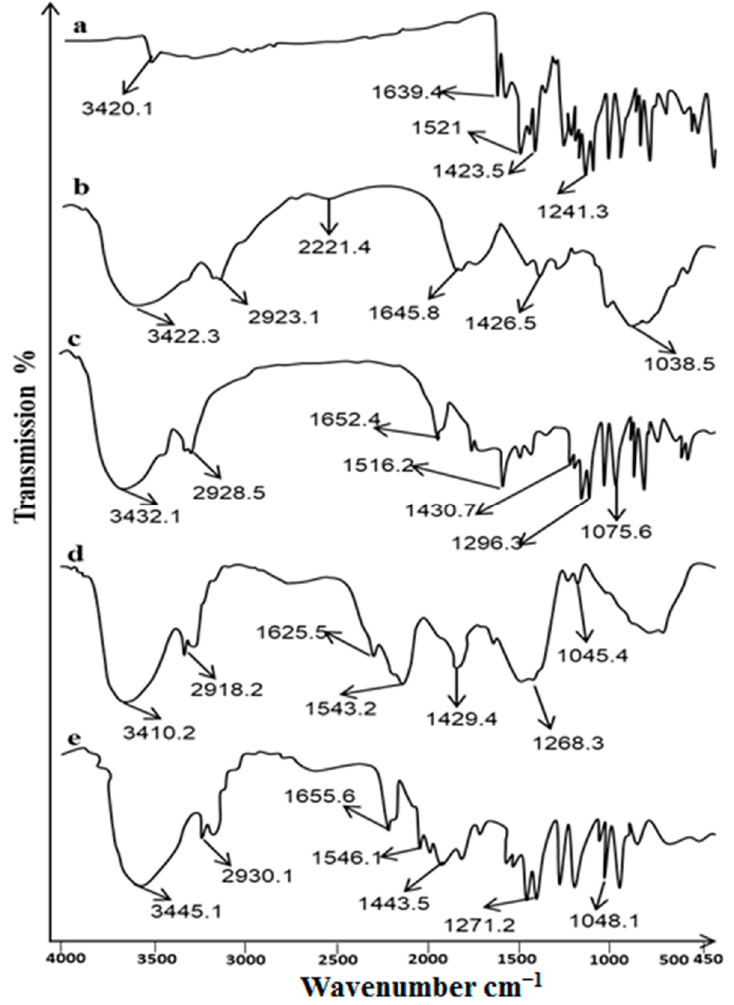
Figure 1. ATR − FTIR spectra of ( a ) Curcumin, ( b ) Chitosan, ( c ) Cur ─ Cs ─ Np, ( d ) Ethyl cellulose and ( e ) Cur ─ Cs ─ Np ─ P. ( e )